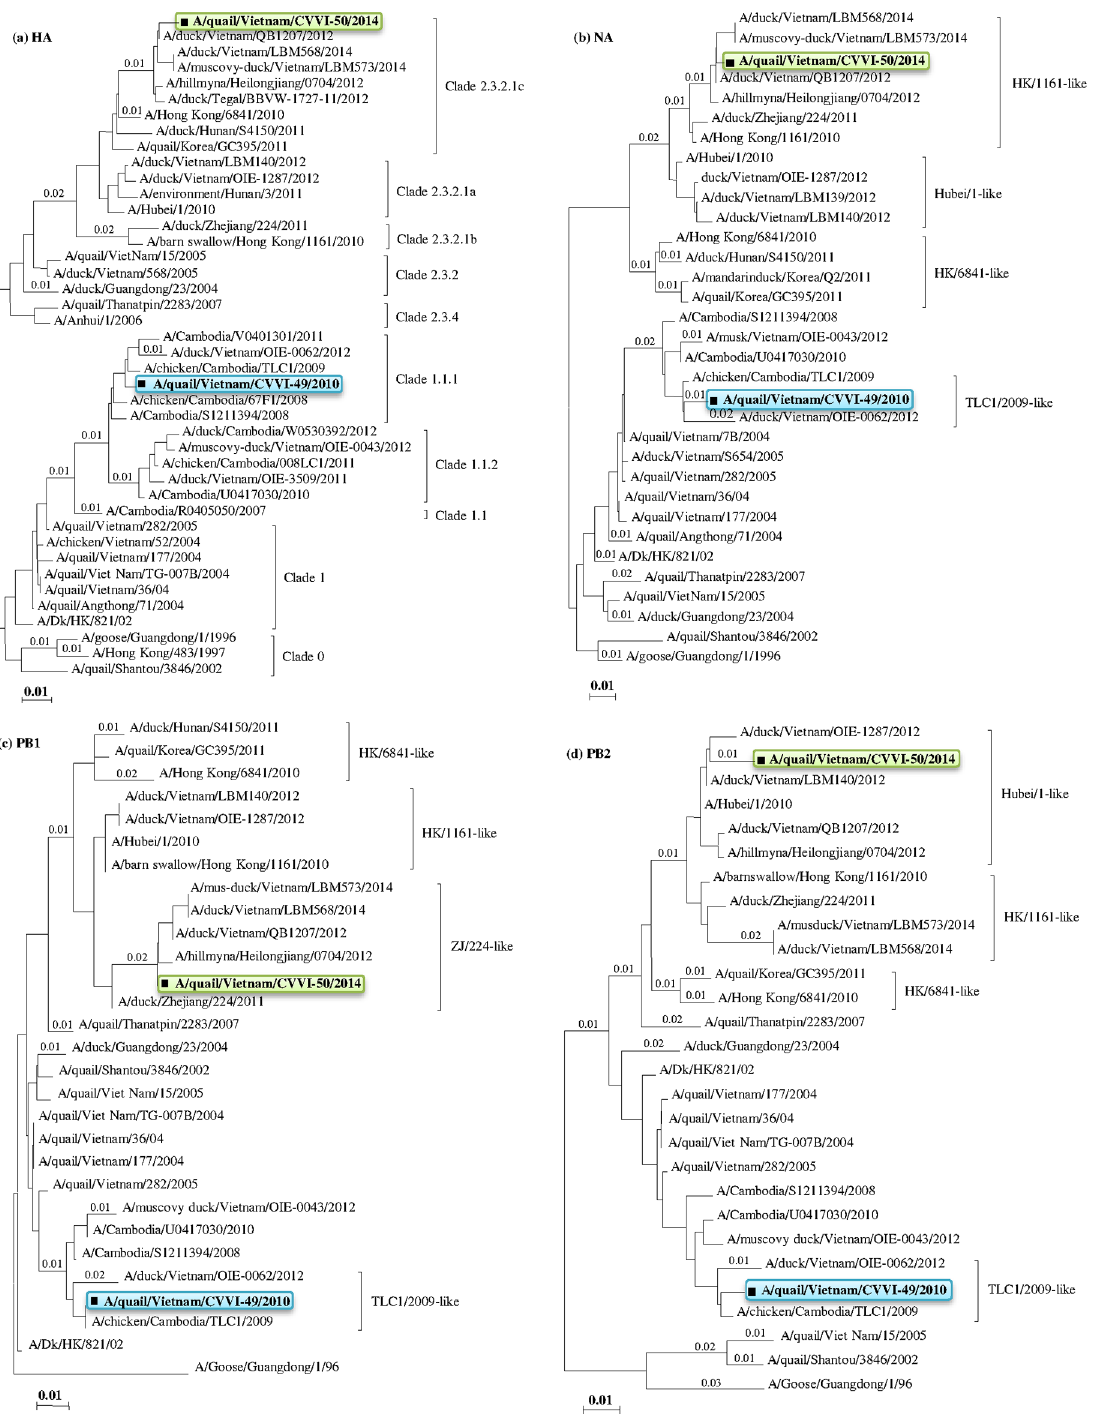
Fig 2. Phylogenetic trees from neighbor-joining analyses of the (a) HA genes, (b) NA genes, (c) PB1 genes, and (d) PB2 genes of the HPAI H5N1 study strains and reference strains available in the GenBank database. The tree topology was constructed using the MEGA 6.06 program and bootstrap values were obtained from 1,000 resampled datasets. HPAI H5N1 virus clade names were determined based on specific criteria and reference strains, as described by the World Health Organization, World Organization for Animal Health, and Food and Agricultural Organization. The study strains are marked in bold and black